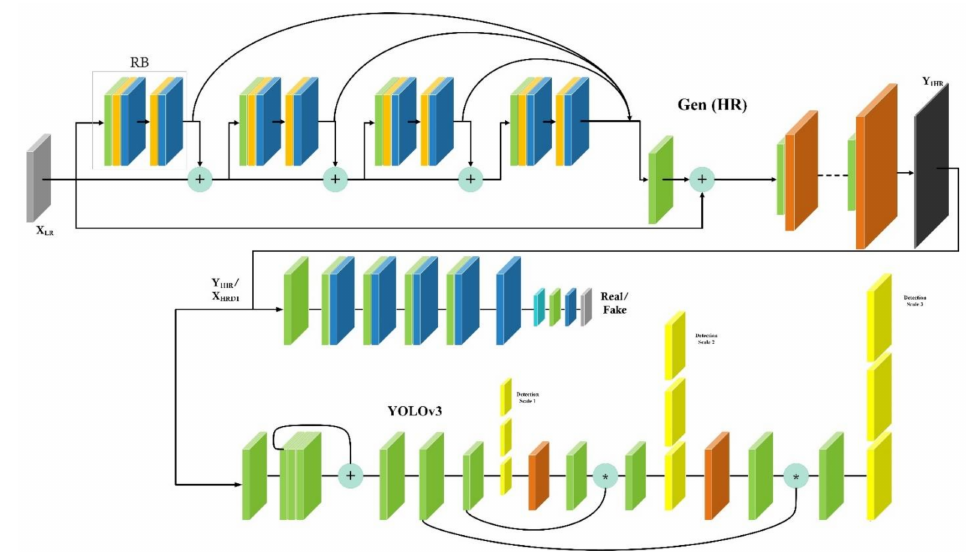
Figure 8. The network architecture for super-resolution SRCGAN with RFA and YOLOv3 detector